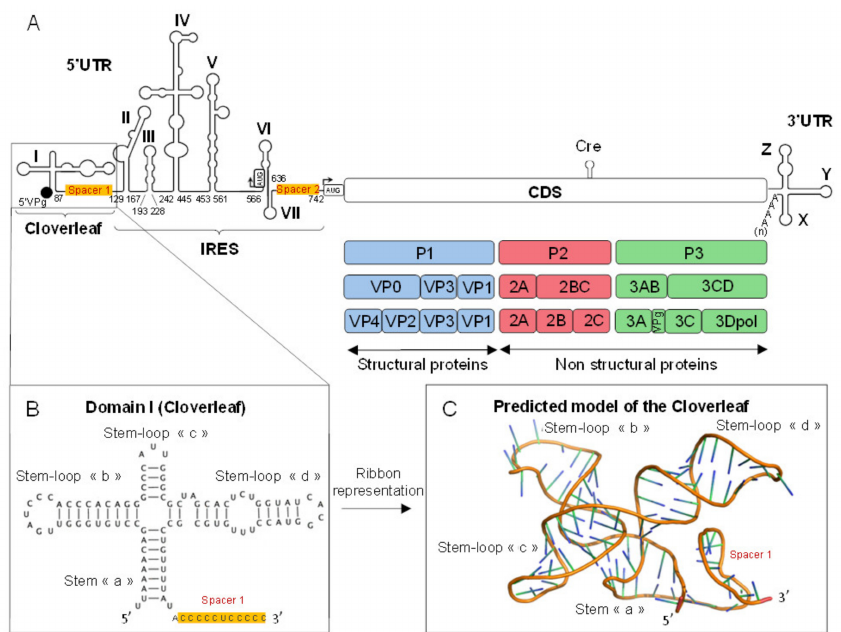
Figure 2. Group-B enterovirus genome organization. ( A ) Enterovirus-B viral genome is composed of two open reading frames (ORFs) which one is a polyprotein coding for capsidic (viral proteins 1 to 4) and non-structural viral proteins such as proteases 2A, 3C, and the 3D polymerase. This long ORF is flanked by two untranslated regions (UTRs): the 5 (cid:48) UTR is composed of a Cloverleaf-like secondary structure (CL, stem-loop I) responsible for the viral genomic replication separated by a spacer sequence comprising two C-rich clusters from an Internal Ribosome Entry Site element type 1 (IRES, stem-loops II to VII) which has a role in the viral translation. Nucleotide numbers are indicated below the structures. ( B , C ) Schematic representation of the predicted 5 (cid:48) end Cloverleaf secondary structures (CL, stem-loop I) of the enteroviral positive strand RNA. The CL is composed of a stem “a” (nucleotides 2–9 with nucleotides 80–87), stem-loop “b” (nucleotides 10–34), stem-loop “c” (nucleotides 35–45), and a stem-loop “d” (nucleotides